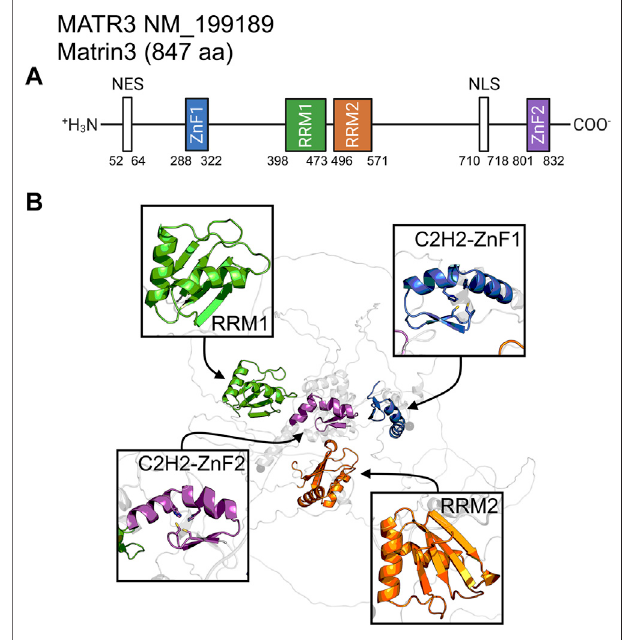
FIGURE1| Matrin3sequenceandstructure. (A) Therelativelocationsof the domains/motifs of Matrin3 (nuclear export signal (NES), Zinc- fi nger motif (ZnF), RNA-recognition motif (RRM) and nuclear localization signal (NLS)) are indicated approximately. Motif assignment is based on Interpro (Blum et al., 2020) and numerical values indicate the boundaries. (B) AlphaFold2 structure prediction of Matrin3, with the two RRM and two ZnF motifs colored to match the sequence graphic. Zinc-coordinating residues are indicated as sticks in the ZnF motif